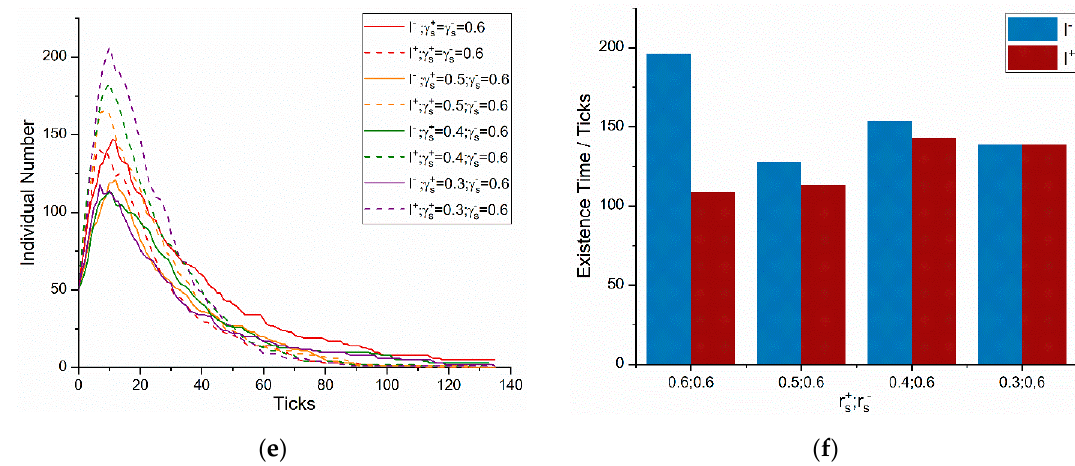
Figure 6. Brand OWOM communication effect when the positive and negative OWOM immune conditions are different. ( a ) The individual number of brand advocators and protesters (with 𝜶 𝑺 (cid:3126) , 𝜶 𝑺 (cid:3127) , 𝜸 𝑺 (cid:3126) , 𝜸 𝑺 (cid:3127) changing); ( b ) the existence time of positive and negative OWOM (with 𝜶 𝑺 (cid:3126) , 𝜶 𝑺 (cid:3127) , 𝜸 𝑺 (cid:3126) , 𝜸 𝑺 (cid:3127) changing); ( c ) the individual number of brand advocators and protesters (with 𝜶 𝑺 (cid:3127) , 𝜸 𝑺 (cid:3127) changing); ( d ) the existence time of positive and negative OWOM (with 𝜶 𝑺 (cid:3127) , 𝜸 𝑺 (cid:3127) changing); ( e ) the individual number of brand advocators and protesters (with 𝜶 𝑺 (cid:3126) , 𝜸 𝑺 (cid:3126) changing); ( f ) the existence time of positive and negative OWOM (with 𝜶 𝑺 (cid:3126) , 𝜸 𝑺 (cid:3126) changing).